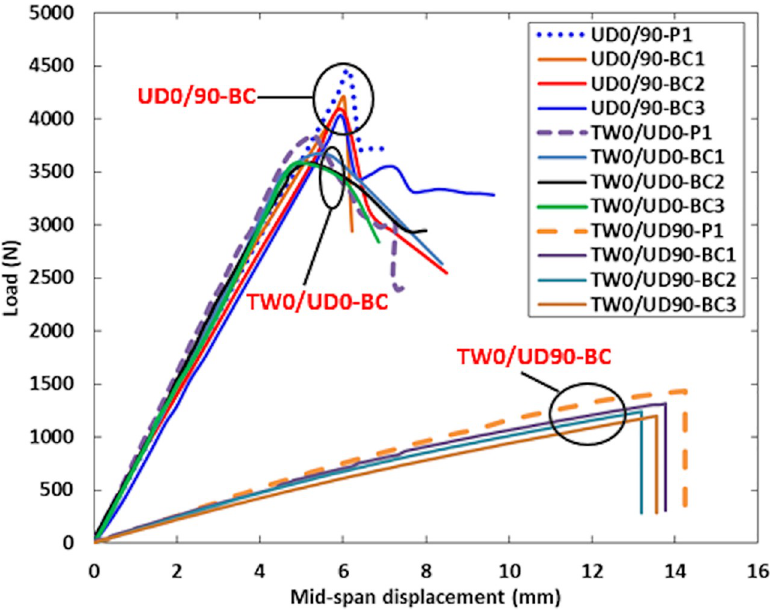
Fig 6. Load against mid-span displacement curve for crack-free SHC beams and those containing pre-existing 10 mm transverse skin crack at the tension side.